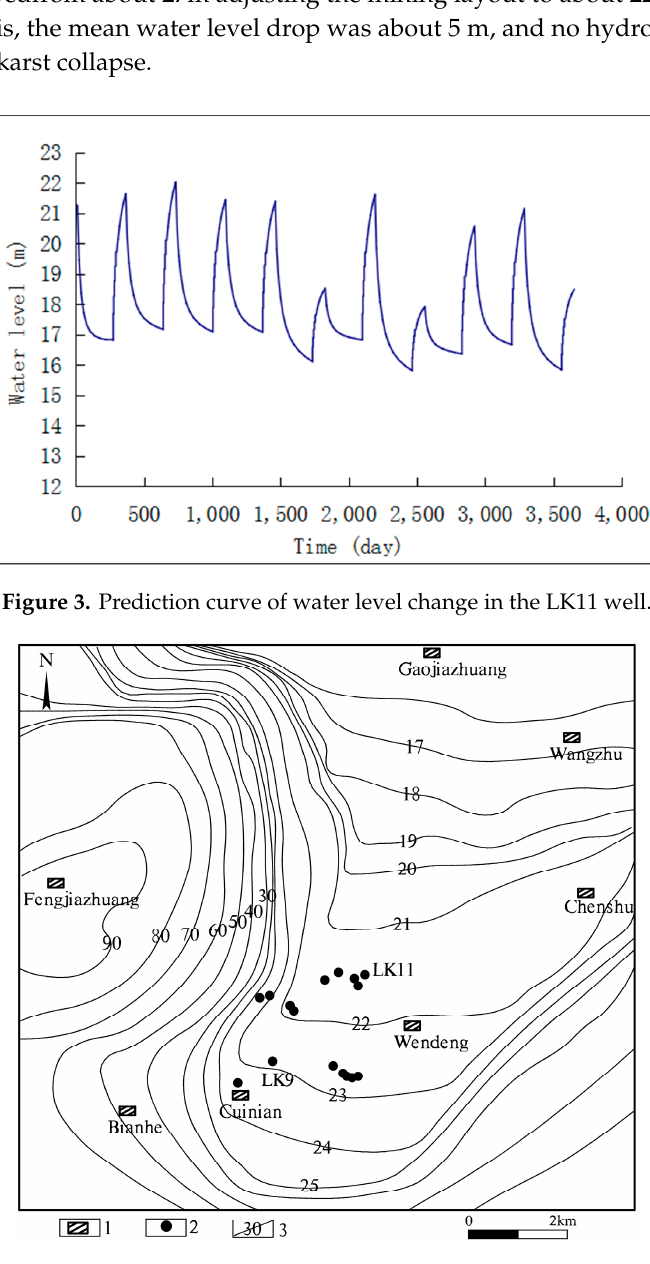
Figure 4. Groundwater plane flow field.1 : village; 2: mining well; 3: groundwater level contour (m).